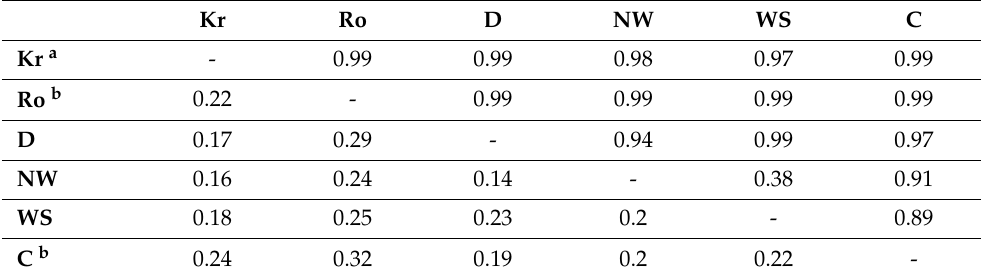
Table 7. Pairwise distances ( KB ; below diagonal) and significance of differentiation ( KW ; above diagonal) between Russian regional Puccinia striiformis populations. Kr Ro D